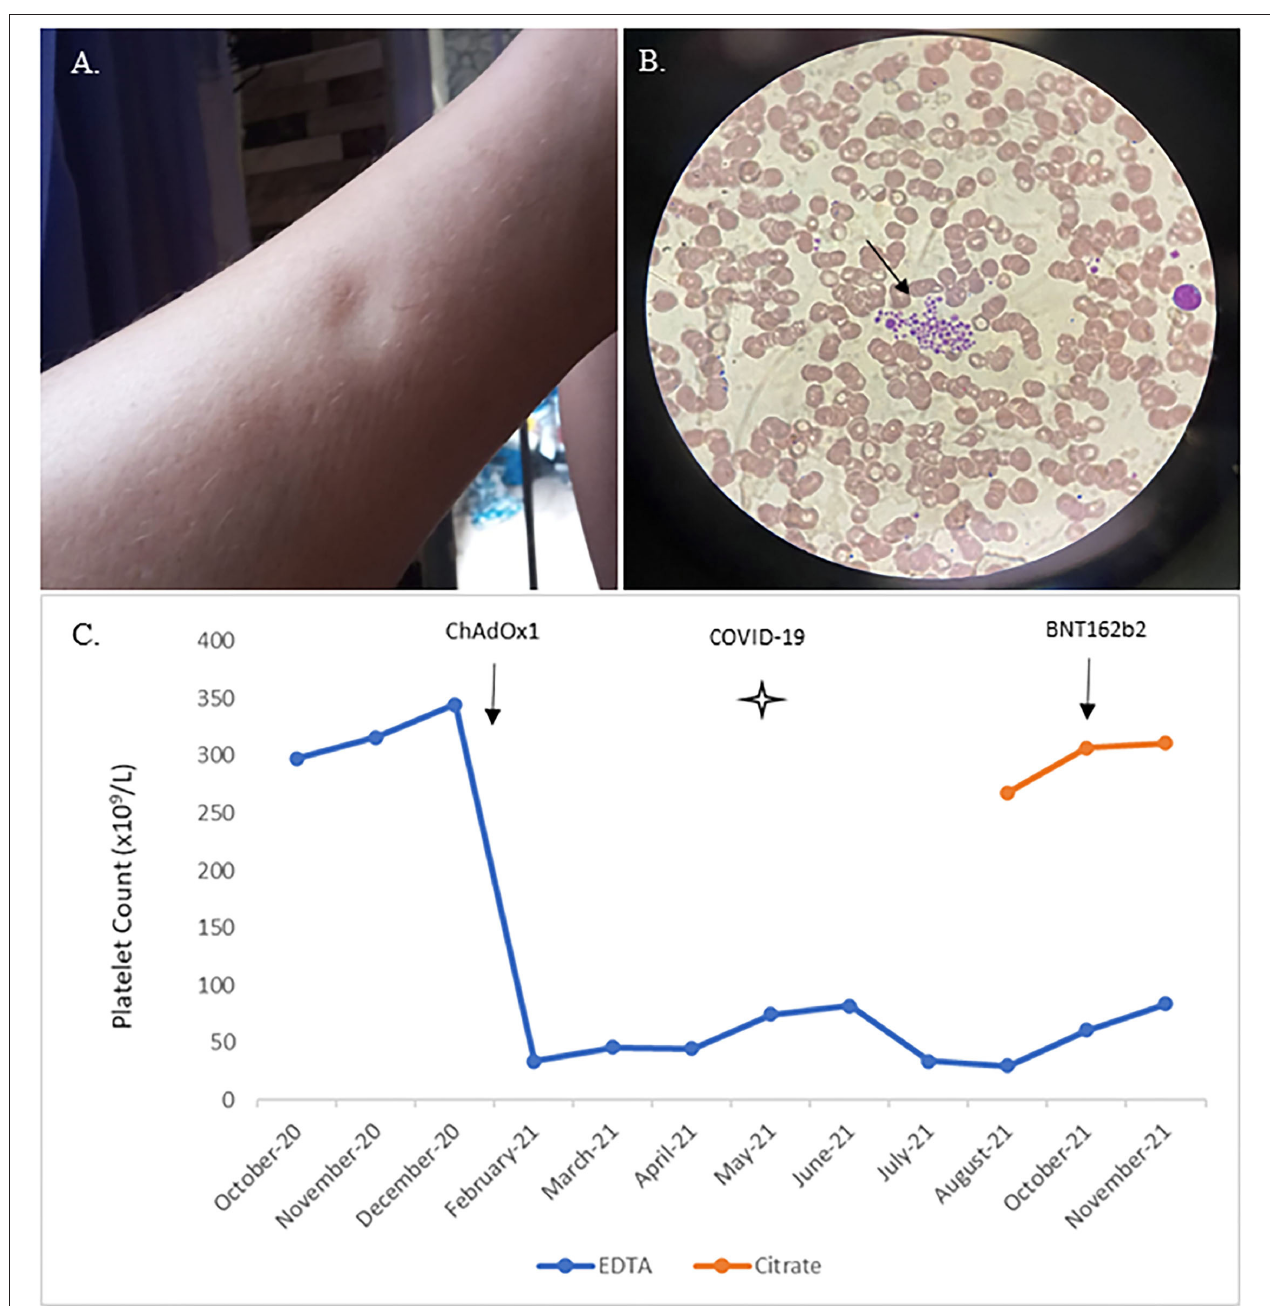
FIGURE 1 | Skin edema, platelet aggregates on the EDTA blood smear, and platelet count evolution in EDTA and citrate anticoagulated blood. Lower limb skin edema in patient 12 days after ChAdOx1 nCoV-19 vaccination, with spontaneous resolution after four months (A) ; Peripheral blood smear from the EDTA-anticoagulated patient’s blood showing platelet aggregates (arrow) (B) ; Platelet counts in EDTA anticoagulation are shown in blue; platelet counts in citrate anticoagulation are shown in orange starting in August 2021. COVID-19 infection is indicated by a star, ChAdOx1 nCoV-19 and BNT162b2 vaccinations are shown by black arrow s (C)